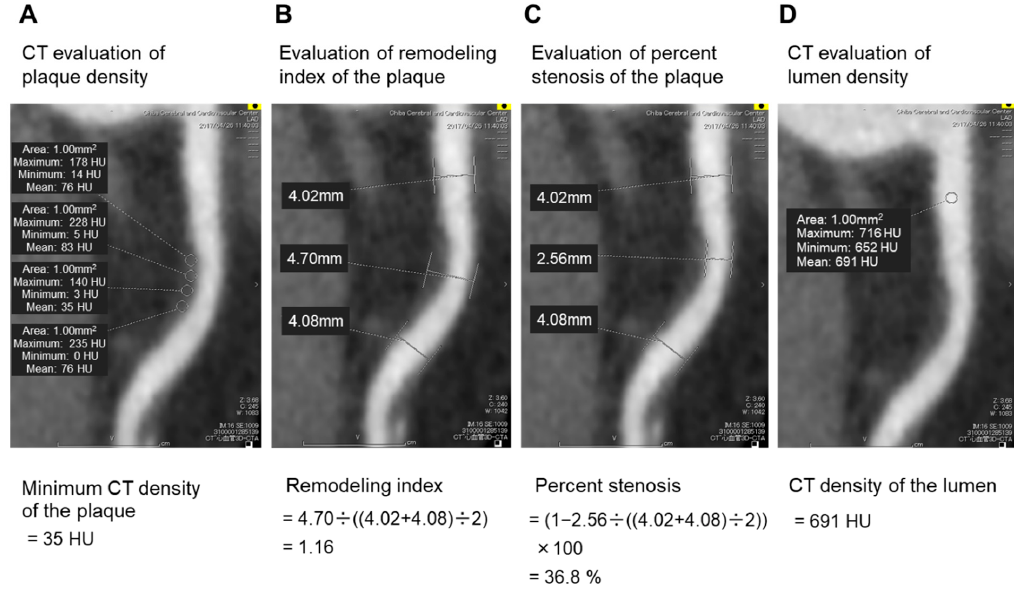
Figure 2. CT angiography imaging of the coronary artery. Several circular regions of interest (with areas of 1 mm 2 ) were placed in the coronary plaque ( A ). Tissue with a CT density < 0 HU was considered pericardial fat surrounding the vessel and excluded from the analysis. The minimum CT density of the plaque was determined by comparing the mean CT density of each circular region of interest. In this case, the mean CT density of each circular region of interest was 76, 83, 35, and 76 HU; therefore, the minimum CT density of the plaque was 35 HU ( A ). The remodeling index was calculated by dividing the maximum vessel diameter in the lesion by the mean of the proximal and distal reference vessel diameters ( B ). In this case, the maximum vessel diameter in the lesion, the proximal reference vessel diameter, and the distal reference vessel diameter were 4.70, 4.02, and 4.08, respectively; therefore, the remodeling index was 1.16 ( B ). The percent stenosis was calculated as a ratio of the minimal lumen diameter to the mean of proximal and distal reference vessel diameters ( C ). In this case, the minimal lumen diameter, the proximal reference vessel diameter, and the distal reference vessel diameters were 2.56, 4.02, and 4.08, respectively; therefore, the percent stenosis was 36.8%. The CT density of the lumen was measured using a circular region of interest placed in the center of the lumen ( D ). In this case, the mean CT density of the circular region of interest was 691 HU; therefore, the CT density of the lumen was 691 HU ( D ). Abbreviation: CT, computed tomography.